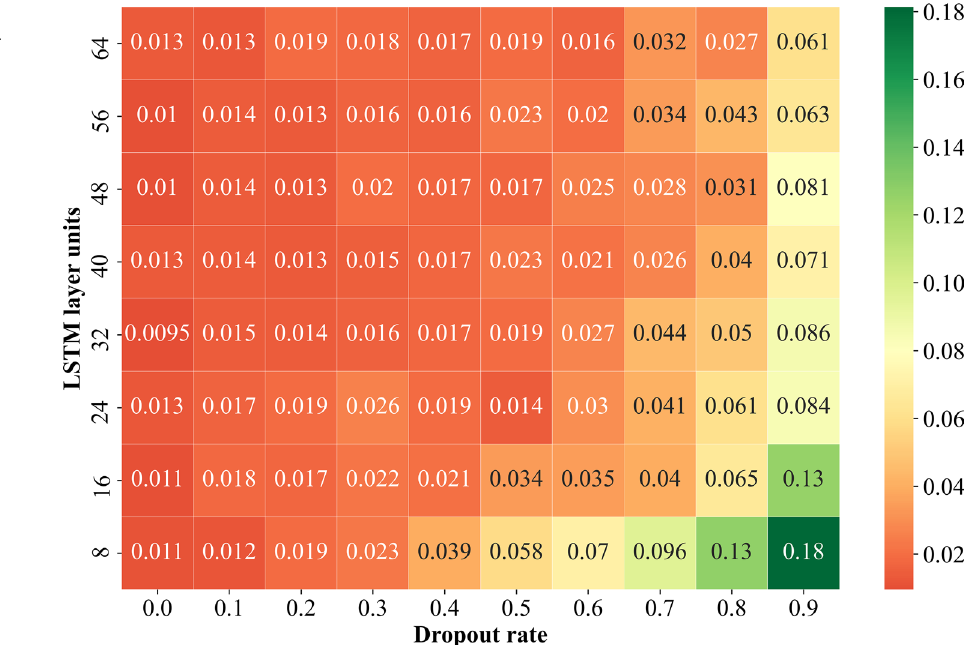
Fig. 11 RMSE for different combinations of units and drop- out rate of